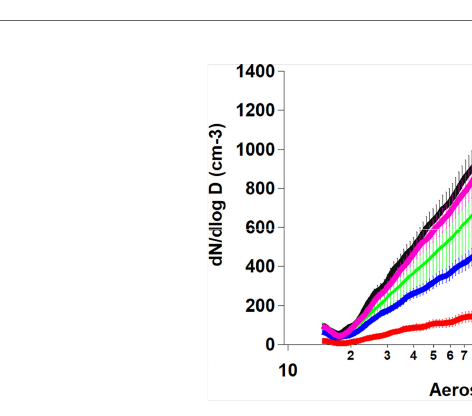
FIGURE 7 | Aerosol size-resolved concentrations (cm-3) of the four sea ice melted samples during the aerosol generation chamber experiments. Differences between beginning and end were small and included in the uncertainties. Aerosol size distributions in green “ sea waters ” are aerosol primary chamber experiments from experiments used in the PI-ICE cruise and obtained from open ocean waters and coastal regions (these campaign data still need to be analyzed and results will be